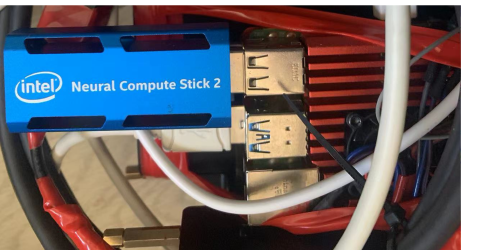
Figure 15. The equipments overview of embedded ARM platform. The Raspberry4B with Cortex-A72 is in the red section, and the blue part is